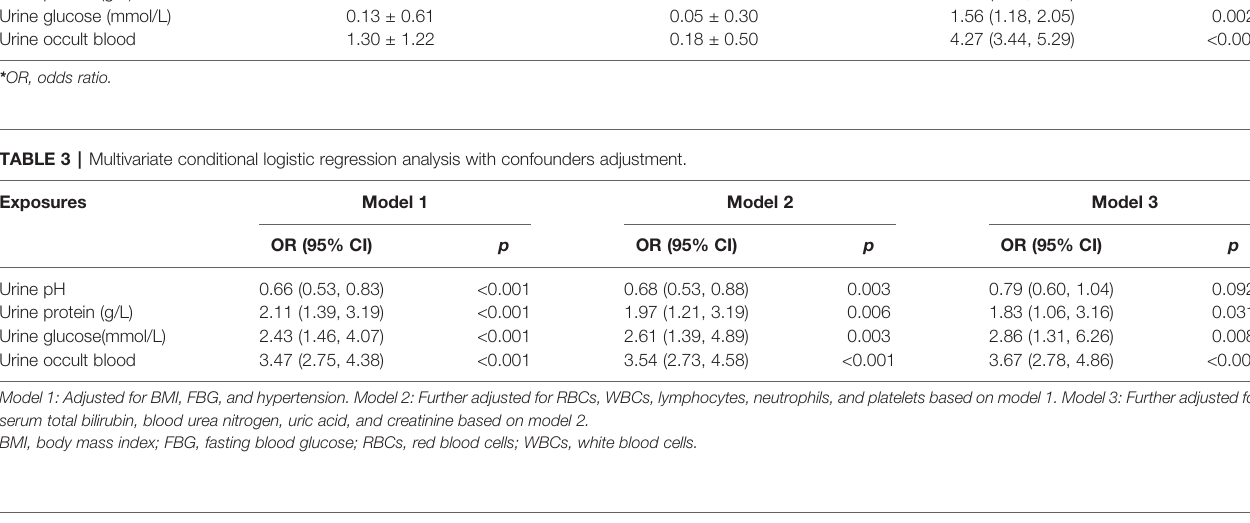
TABLE 4 | Spearman ’ s correlation coef fi cients between T stage and urine parameters. Variable